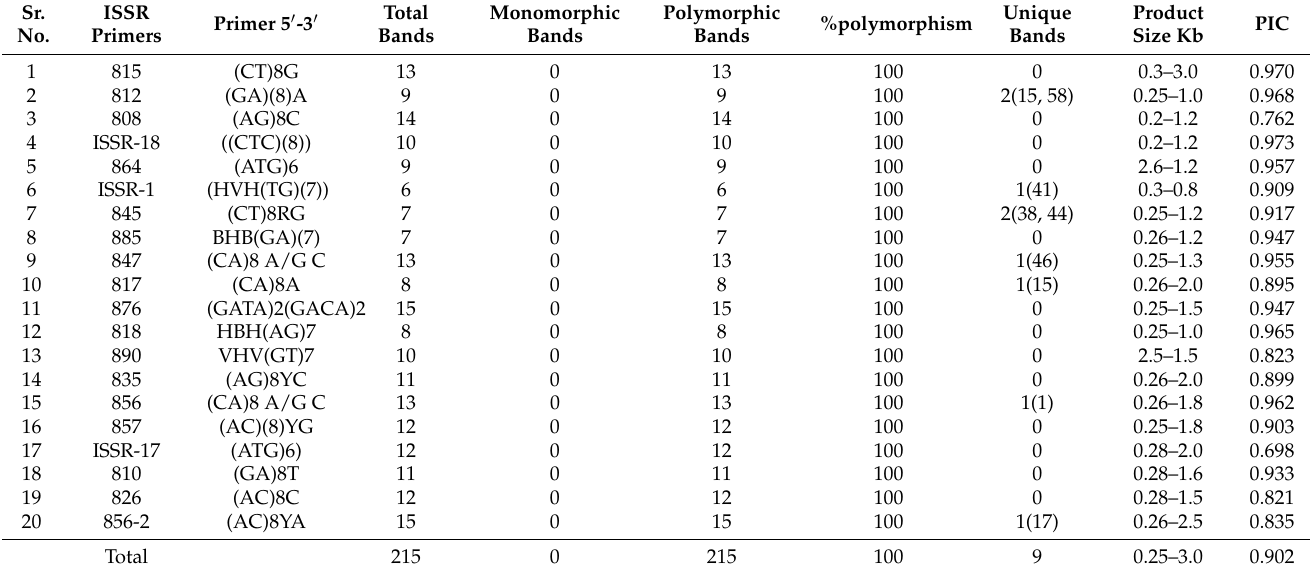
Table 6. Characteristics of different inter-simple sequence repeat (ISSR) primers in T. indica isolates.